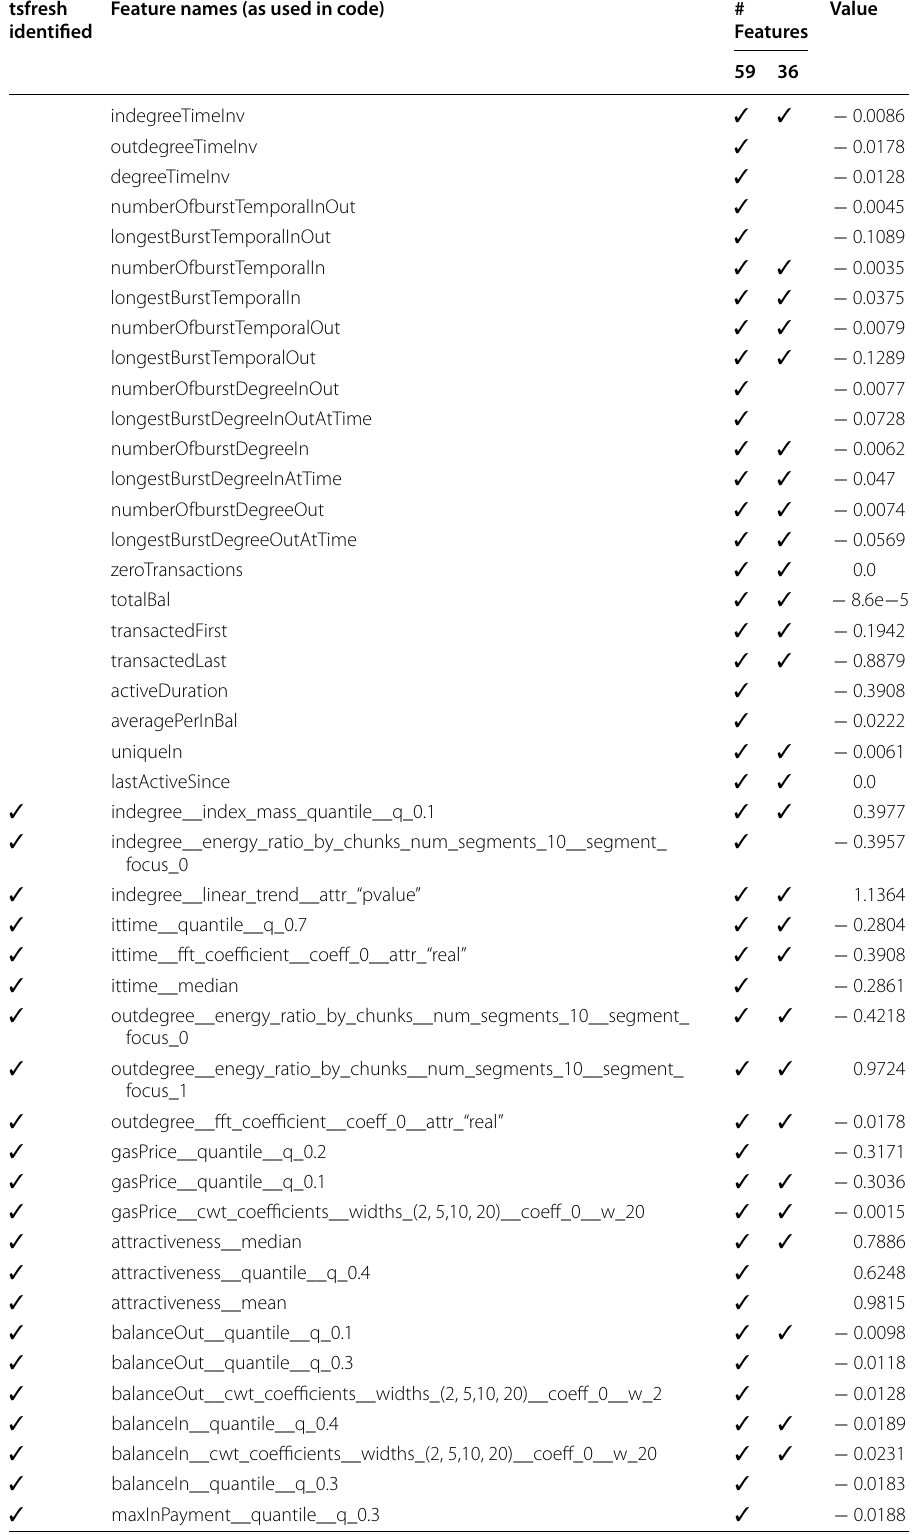
Table 4 Sample feature